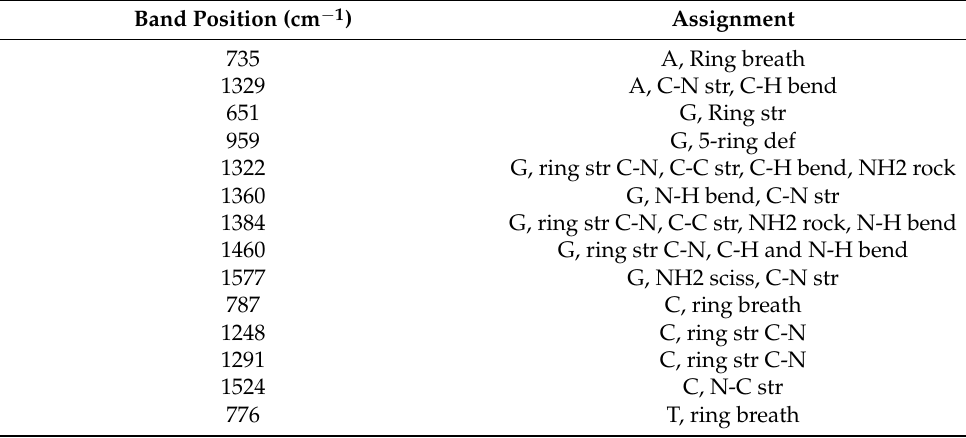
Table 1. Peak position and possible assignment for the main features identified in the average Raman spectra of Figure 1A,B for adenine (A), guanine (G), cytosine (C) and thymine (T). Assign- ments follow refs 25, 26 and 27.